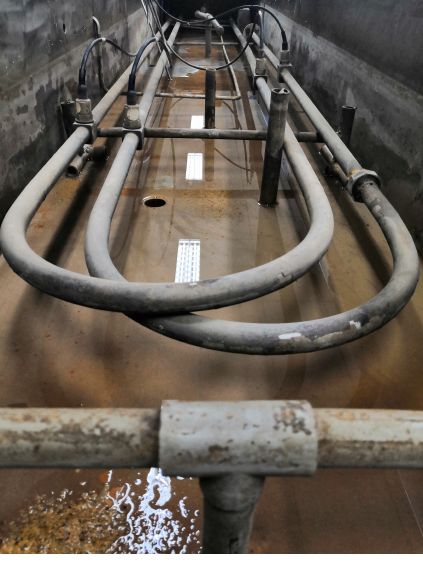
Figure 10: Pressure of pressure transducers during loop restart